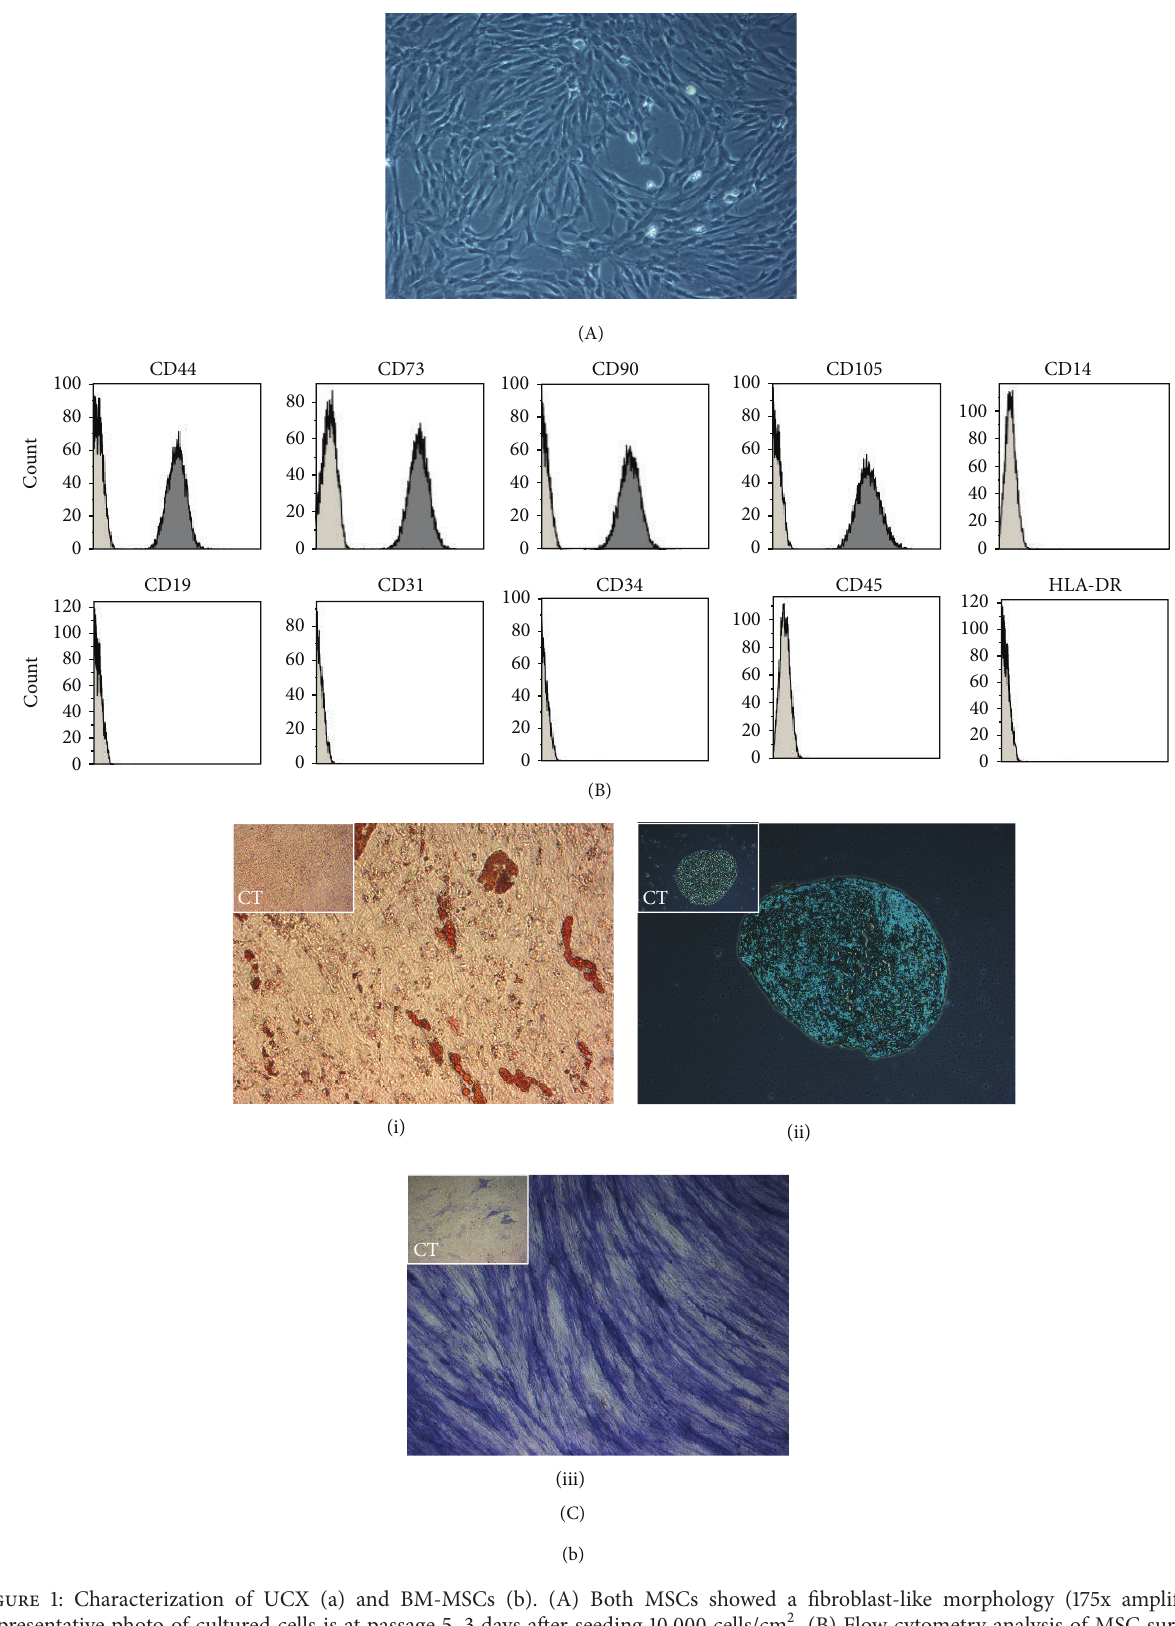
Figure 1: Characterization of UCX (a) and BM-MSCs (b). (A) Both MSCs showed a fibroblast-like morphology (175x amplified). Representative photo of cultured cells is at passage 5, 3 days after seeding 10.000 cells/cm 2 . (B) Flow cytometry analysis of MSC surface- markers expression of cells expanded for 5 passages. (C) Both MSCs were capable of trilineage differentiation. After 21 days of exposure to adipogenic, chondrogenic, and osteogenic differentiation media, results showed (i) Oil Red O staining for adipocytes, (ii) alcian blue staining for chondrocytes, and (iii) alkaline phosphatase staining for osteoblasts. Controls (CT) are shown in the upper left corner of each differentiation